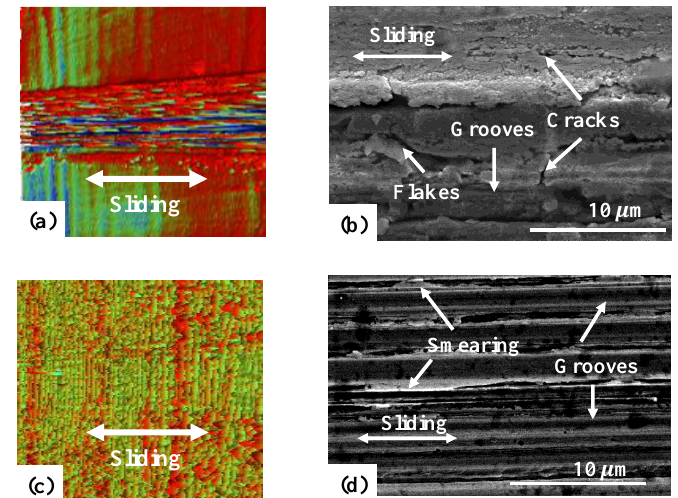
Figure 11. The morphologies of the worn surfaces: ( a ) 3D topography and ( b ) SEM image of crystalline Pd with sliding speed of 3 mm / s and ( c ) 3D topography and ( d ) SEM image of amorphous Pd alloy with sliding speed of 3 mm / s under the IL lubrication at 200 ◦